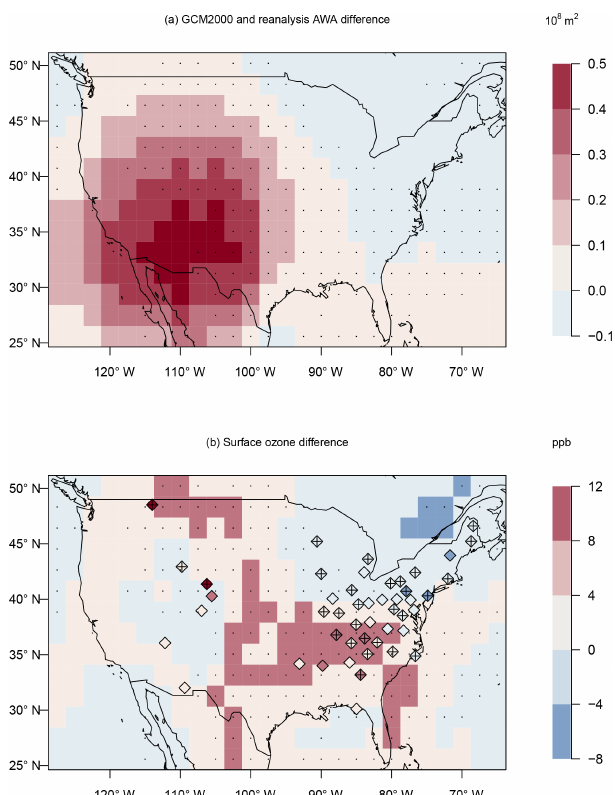
Figure 6. (a) JJA difference in AWA between the GCM2000 sim- ulation (2006–2025) and the ERA-Interim reanalysis (1995–2014) (10 8 m 2 ). (b) Change in MDA8 ozone from the linear regression model derived from the GCM2000 simulation (shaded) or the mea- surements (diamonds) using the AWA difference (calculated from GCM2000 simulation and ERA-Interim reanalysis) projection as the explanatory variable. Plus signs and stippling represent where the ozone difference is significant (at the 5% significance level) at CASTNET sites and model grids,